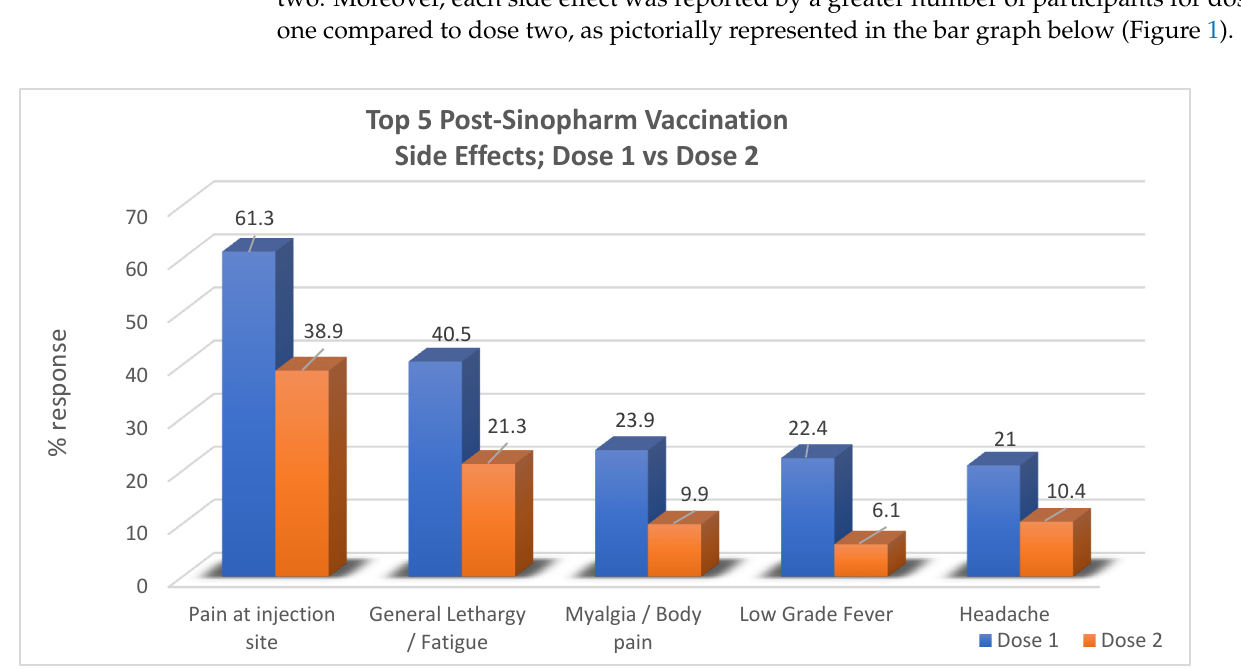
Figure 1. Comparison between the outcome regarding adverse effects for dose one and dose two of the Sinopharm vaccine.